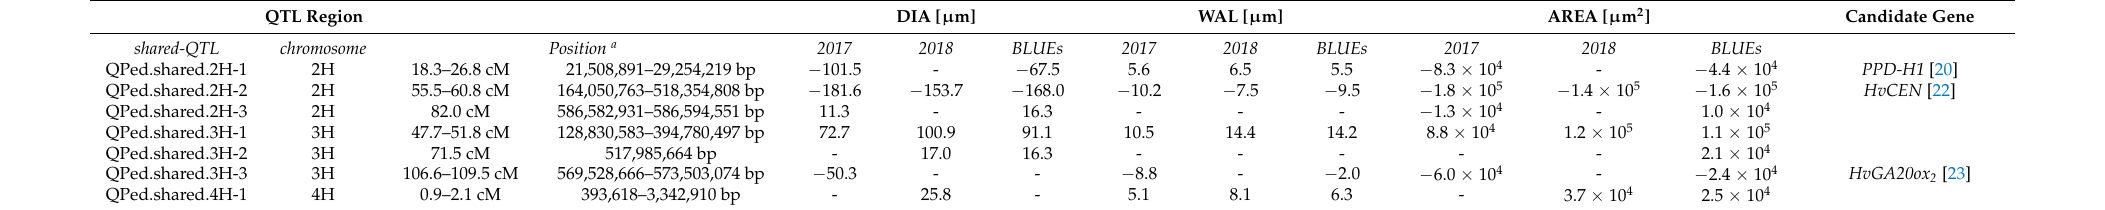
Table 4. Mean wild allele effects of peak markers (DR > 20) of selected quantitative trait locus (QTL) regions. QTL Region DIA [ µ m] WAL [ µ m] AREA [ µ m 2 ] Candidate